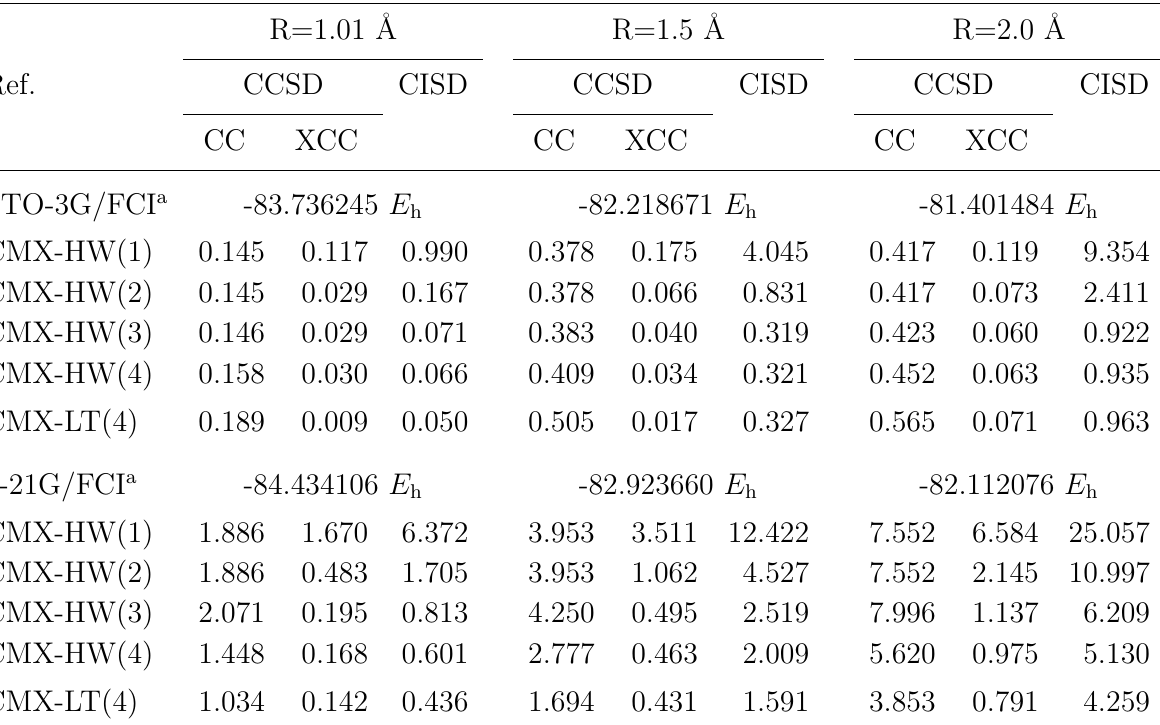
Table 2: Deviations of the CMX energies (in m E h ) from the full CI energies for the H 2 O molecule ( α =104 . 0